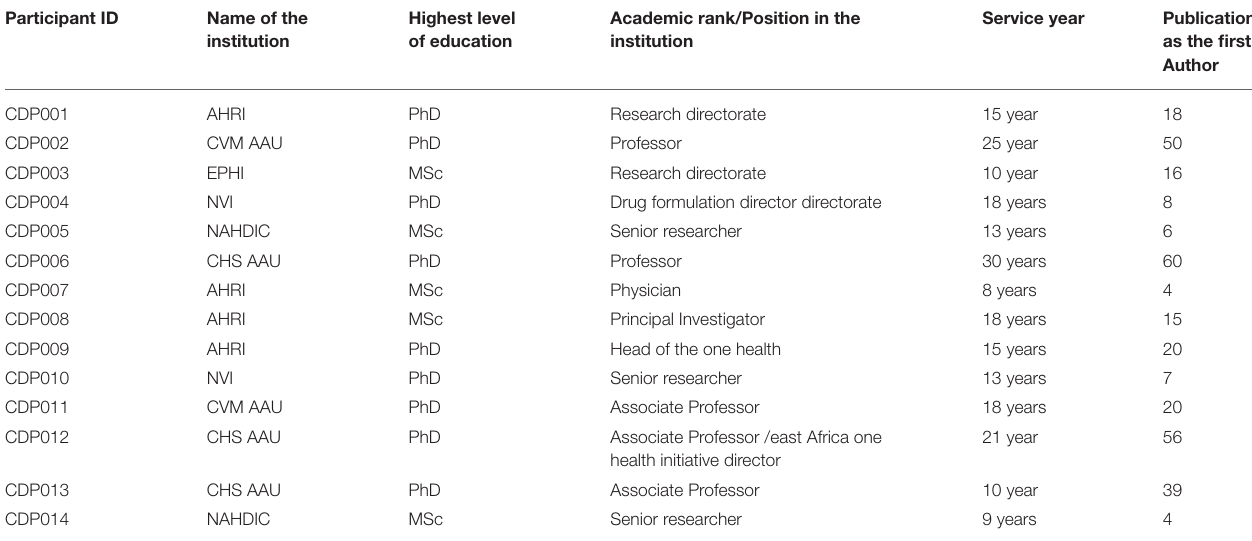
TABLE 1 | Participants demographic